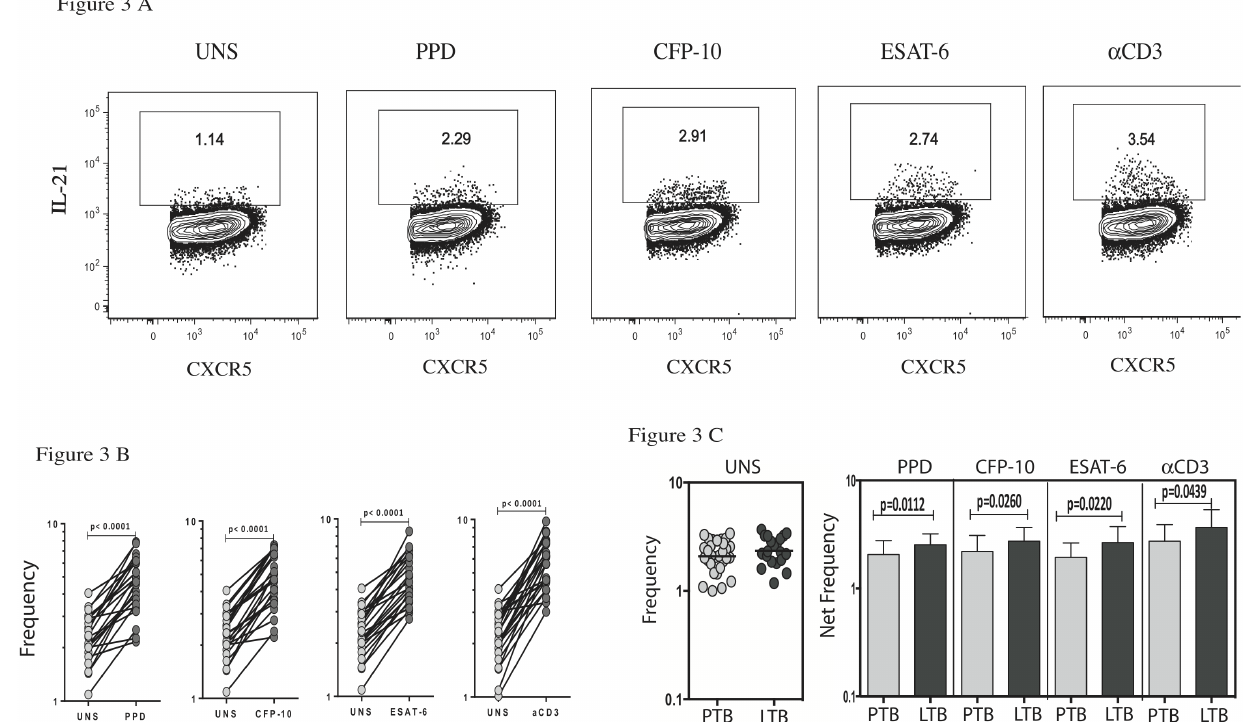
Figure 3. Diminished antigen - specific frequencies of IL-21 expressing Tfh cells in PTB. (A) Whole blood from PTB and LTB individuals was stimulated with PPD, CFP-10, ESAT-6 and anti-CD3 for 6 h, and the frequencies of CD4 + CXCR5 + IL-21 + T cells were estimated by flow cytometry. A representative dot plot is shown. (B) TB antigen- and anti-CD3-induced expansion of IL-21 expressing Tfh cells in PTB. (C) The spontaneous and TB - antigen stimulated frequencies of IL-21 expressing Tfh cells in PTB and LTB individuals. P values were calculated using either Wilcoxon signed rank test or Mann-Whitney U test.